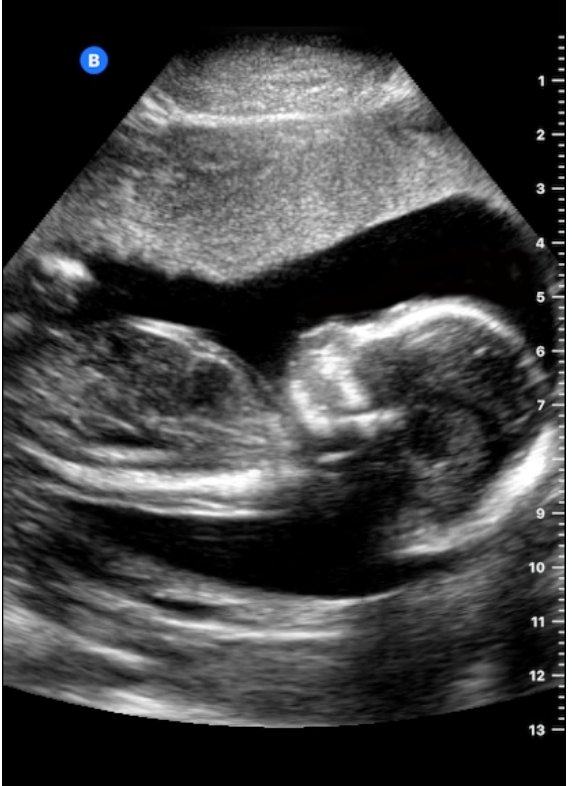
Figure 15. A fetal B-mode scanned with a CMUT transducer reproduced with permission from Butterfly Network